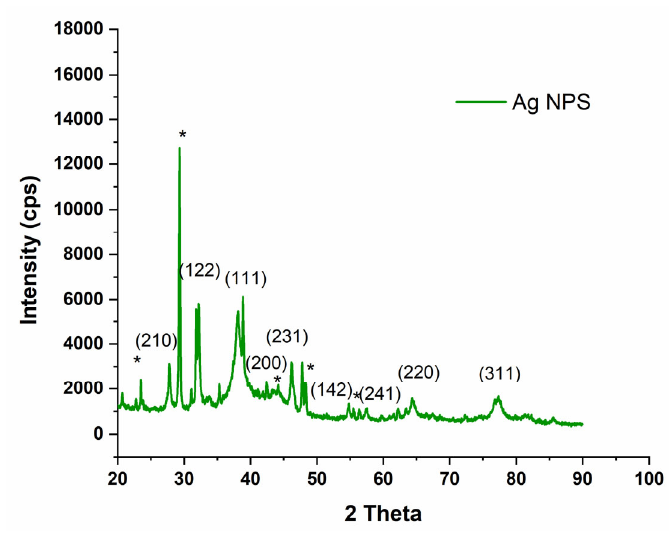
Figure 6. PXRD analysis of the synthesized SNPs.